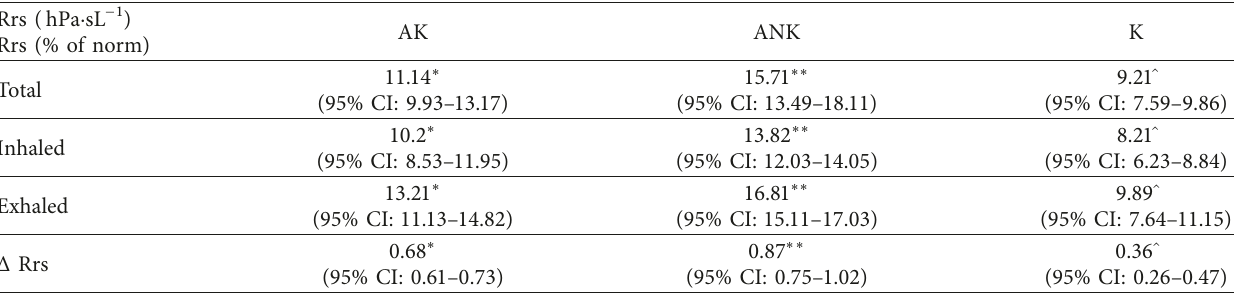
Table 2: Comparison of Rrs values in the studied groups.